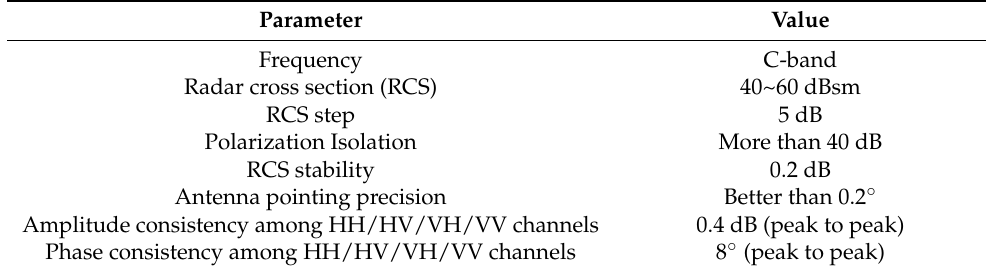
Table 1. Specifications of the polarimetric active radar calibrator (PARC).